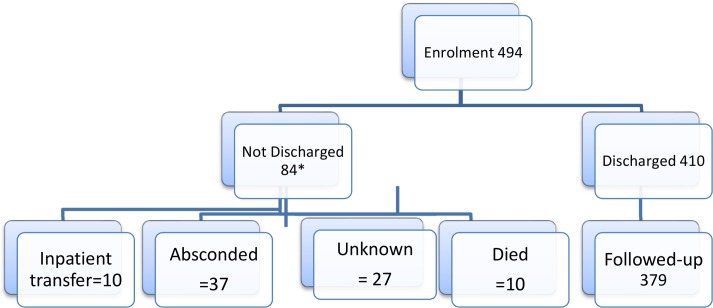
Flow chart of subjects.